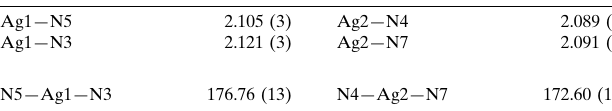
Selected geometric parameters (A˚ , (cid:3) ).